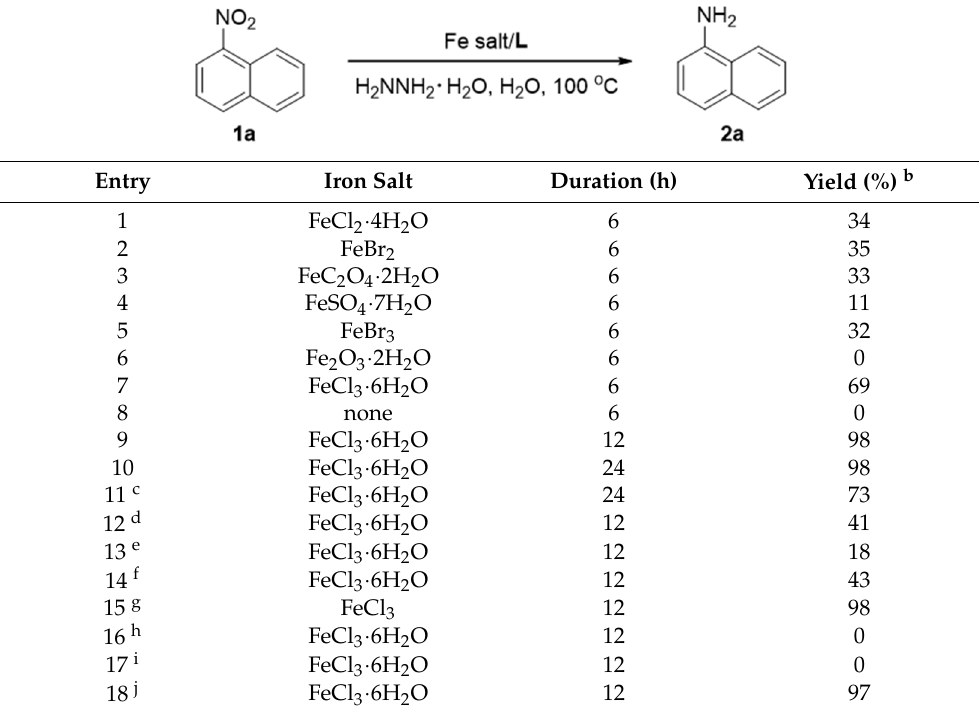
Table 2. Iron-catalyzed hydrogenation of 1-nitronaphthalene in water a .